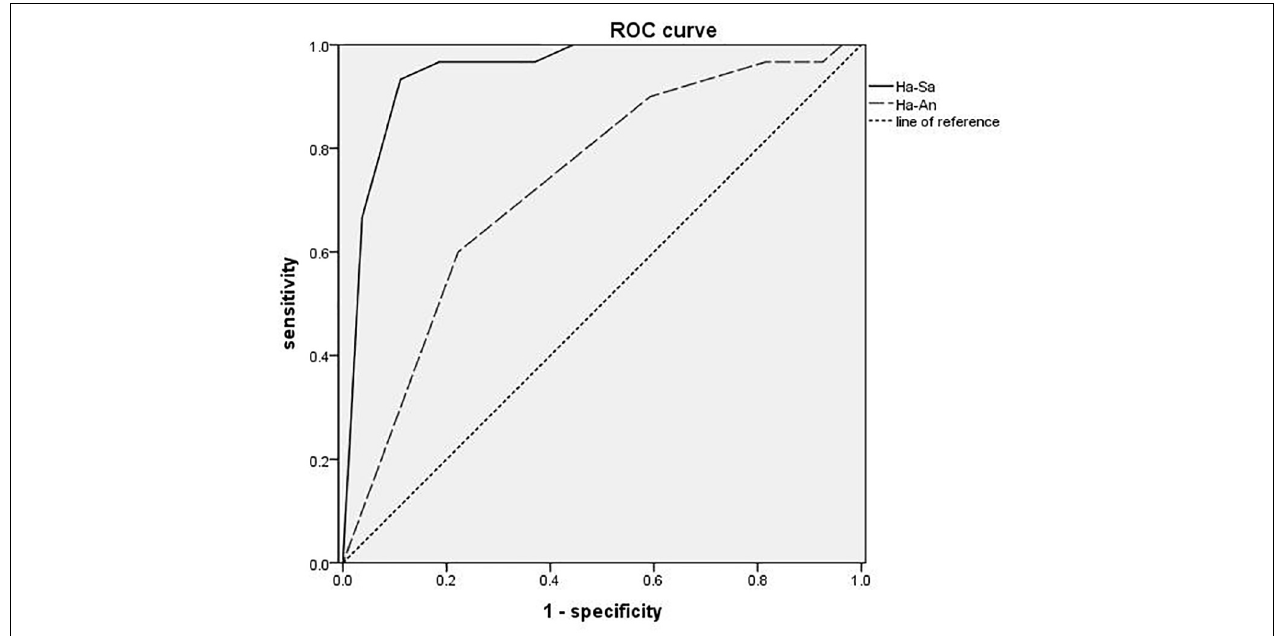
FIGURE 4 | ROC curve of distinguish unipolar and bipolar